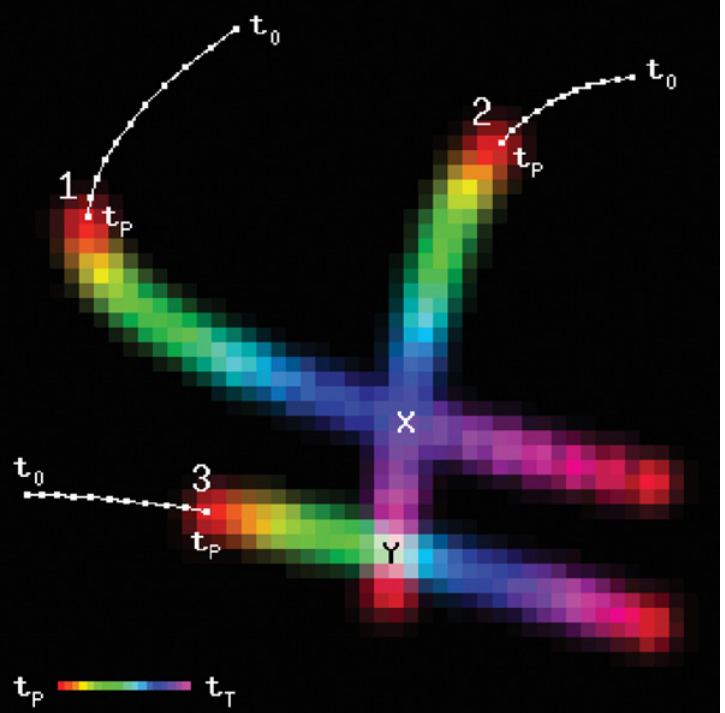
Fig 1. Collision matrix M for three moving obstacles. The observed trajectories are shown as white lines, and the predicted location is shown as a colored area. For visualization purposes, motion noise has been